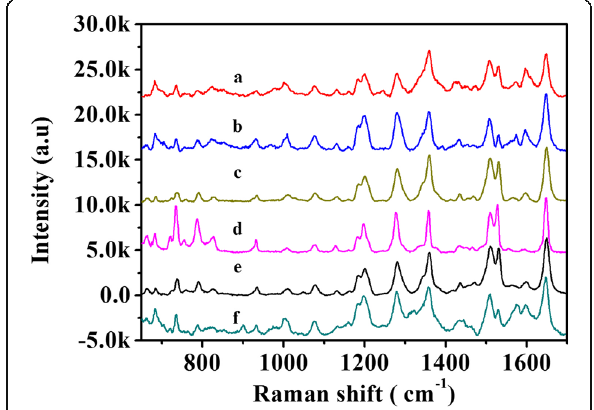
Fig. 9 SERS spectra of 10 – 6 M RB on the flexible